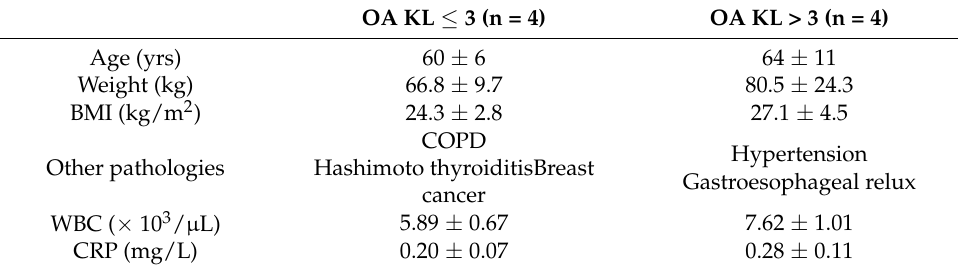
Table 1. Demographic and clinical data of selected